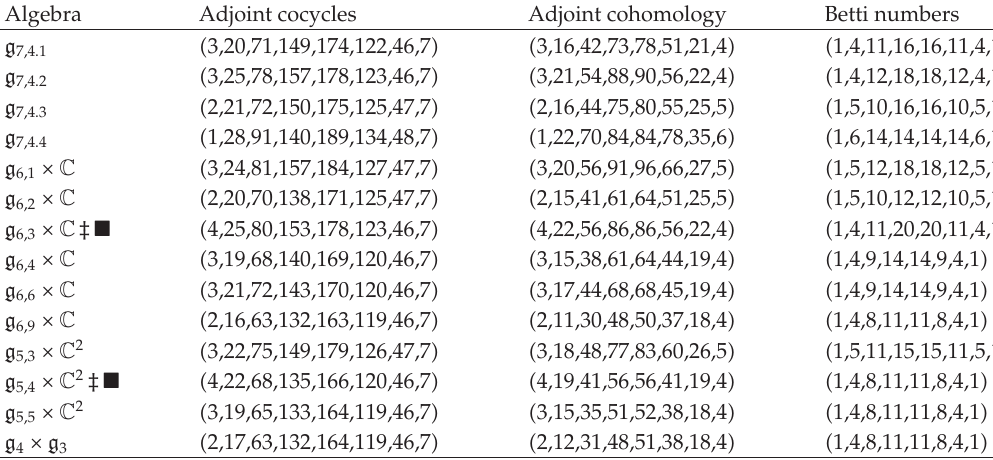
Table 7: Cohomology table for NLAs of dimension 7: rank 4.